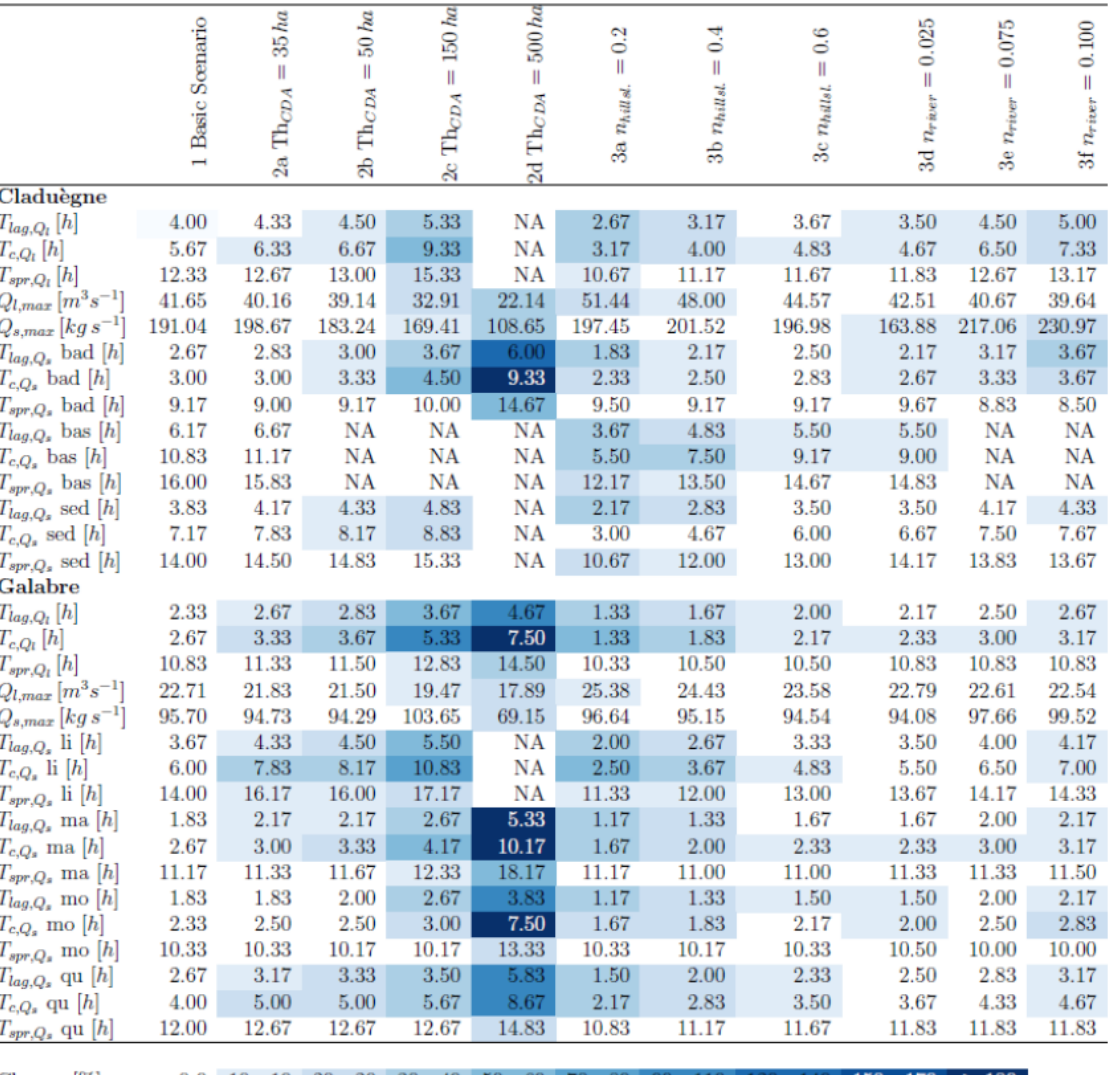
: Table 3. Calculated characteristics of modeled hydrographs and sedigraphs for the different scenarios. Abbreviations are as follows. T lag ,Q l lag time of liquid discharge, T c ,Q : time of concentration of liquid discharge, T spr ,Q : spread of the hydrograph, Q l , max : peak of liquid l l discharge. Q s refers to solid discharge, and the characteristic times are calculated for each source separately (i.e., badlands, basaltic, and sed- imentary in the Claduègne catchment; limestone, black marl, molasses, and Quaternary deposits in the Galabre catchment). The background color of the cells represents the percent change of each value with respect to the basic scenario. NA values indicate that the hydrograph or sedigraph did not recede to 0 . 1 Q max within the simulated